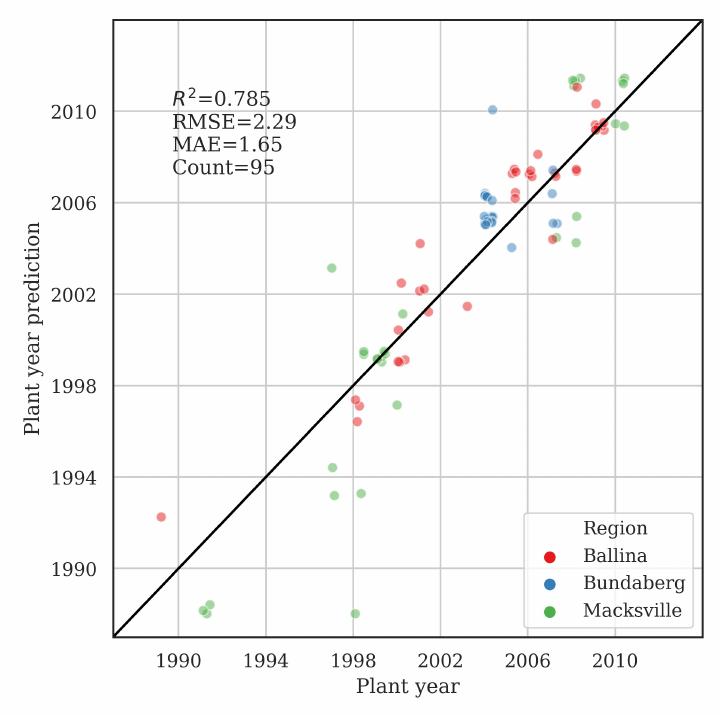
Figure 5. Predicted vs. actual planting year, using the best algorithm with NDVI mean , y ∆ = 3 with a threshold of 0.62. Slight jitter has been added to the x and y values of each point so multiple points lying on the same co-ordinates are